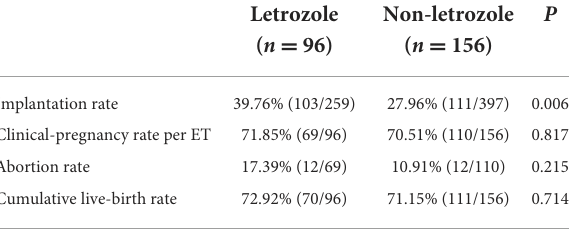
TABLE 4 Cumulative reproductive outcomes in the study groups.